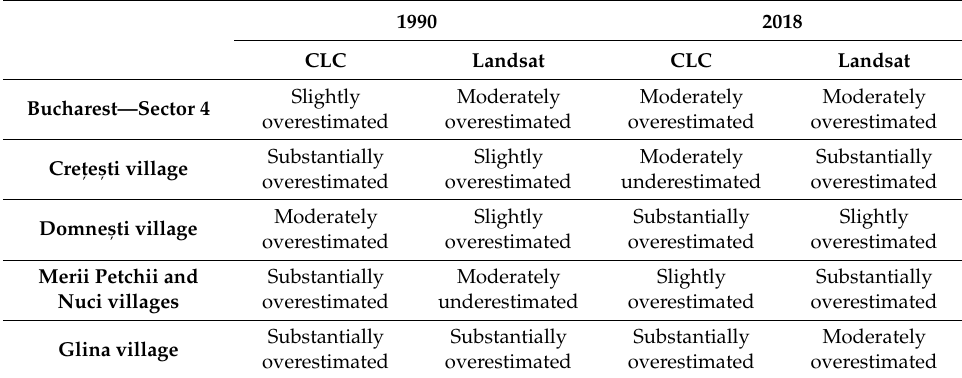
Table 4. Synthetic comparison of the built-up area mapping, at the local level, between CLC and Landsat